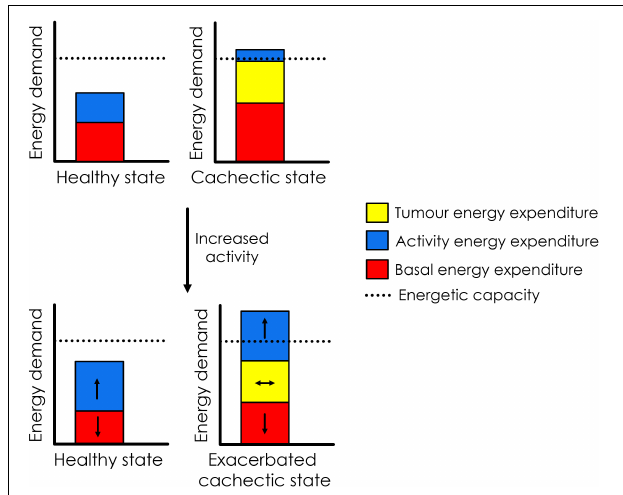
FIGURE 1 | Hypothesised effect of increasing physical activity on energetics in patients with cancer cachexia. In the pictured, hypothetical scenario, increased physical activity results in a decrease in basal energy expenditure due to energy compensation. In healthy individuals, total energy expenditure remains well below energetic capacity. However, in the cachectic cancer patient (who is already in energy deficit due to high expenditure by the tumour and systemic inflammation, as part of basal energy expenditure), increased activity may result in downregulation of basal energy expenditure (possibly impairing anti-tumour immunity), while still pushing energy demand beyond energetic capacity. It is possible that this could exacerbate the cachectic